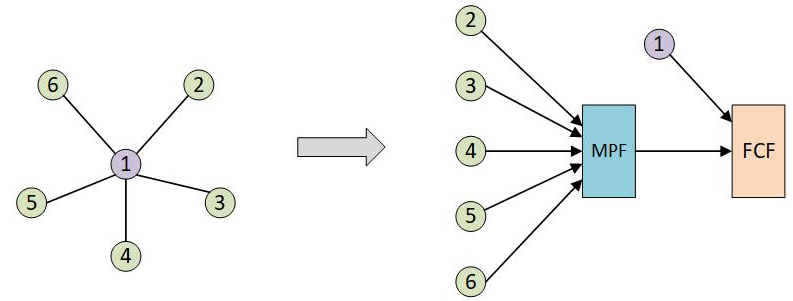
Figure 1. The illustrations of the AGGREGATE and COMBINE functions. To learn the representation of node 1, the AGGREGATE function aggregates the neighbor information of node 1. Then, the COMBINE function combines the aggregated information and the information of node 1